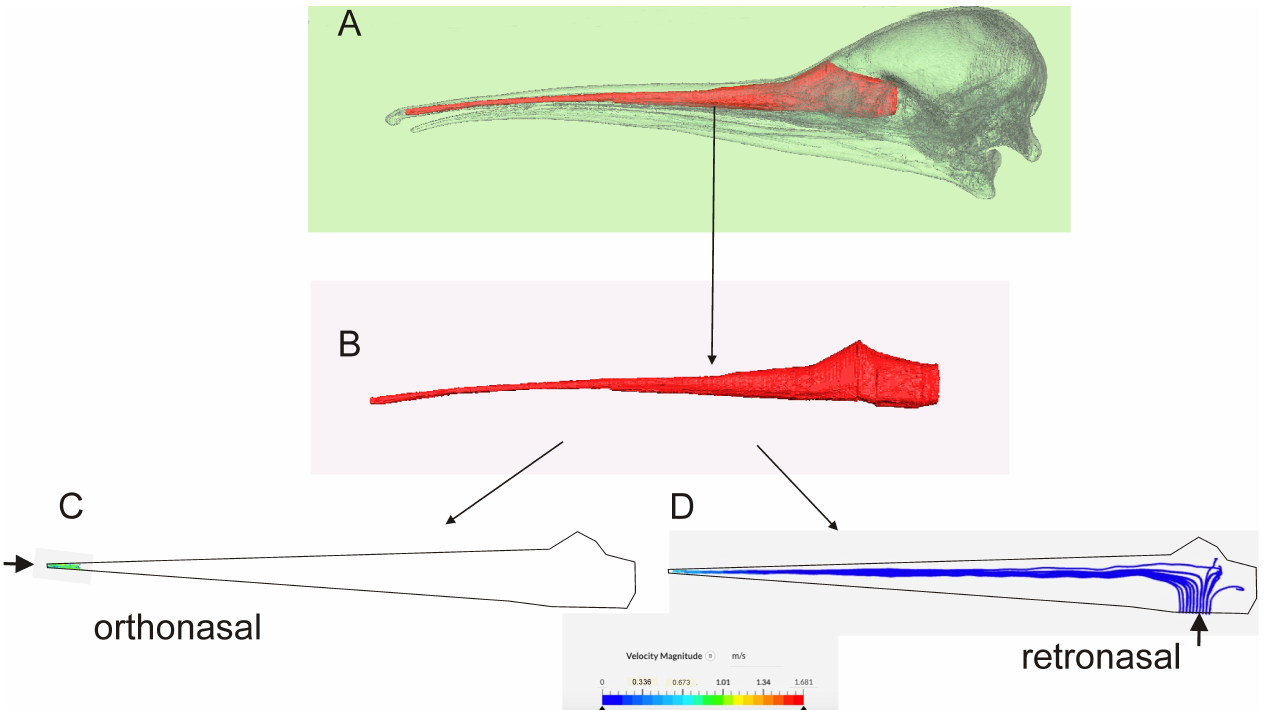
Figure 5. Computational flow dynamics; nasal cavity ( A ) in situ ( B ) isolated ( C ) and ( D ), flow